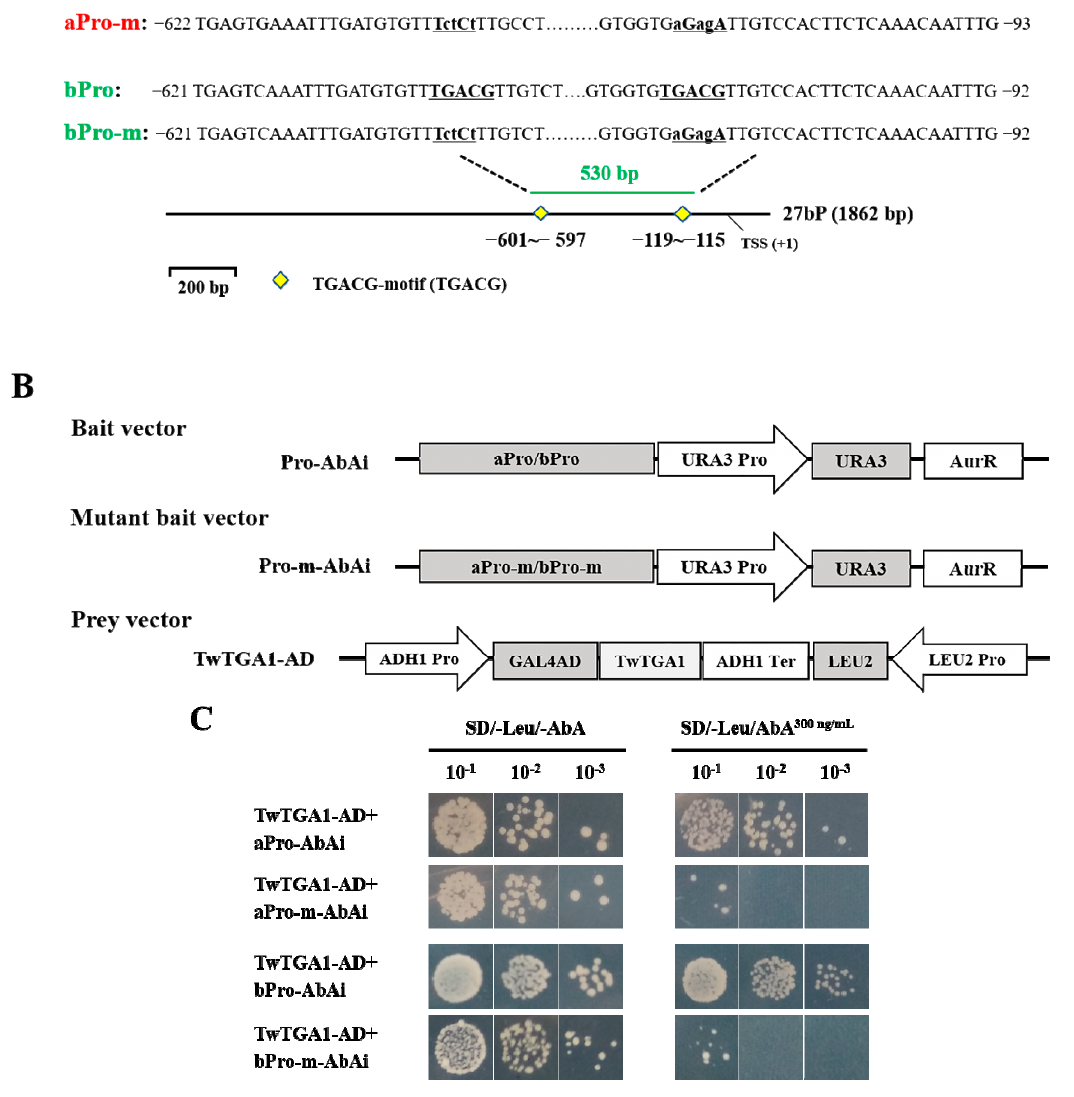
Figure 3. Yeast one-hybrid (Y1H) assays showing that TwTGA1 specifically binds to the TGACG-motif present in the TwTPS27a/b promoters. ( A ) Schematic diagrams of the promoter and mutant promoter fragments in the TwTPS27a ( − 622~ − 93, 530 bp) and TwTPS27b ( − 621~ − 92, 530 bp) used for the construction of the bait and mutant bait vectors. The yellow diamond represents the TGACG-motif. aPro and bPro are both 530 bp containing two ‘TGACG’ elements, while aPro-m and bPro-m are mutated forms of aPro and bPro (‘TGACG’ mutated to ‘TctCt’ by PCR cloning). ( B ) Schematic diagrams of the bait, mutant bait, and prey vectors used for Y1H assays. ( C ) Y1H assays showing the interaction between TwTGA and the TGACG-motif present in the TwTPS27a/b promoters, based on the ability of the transformed yeast strains to grow on SD/ − Leu/AbA 300ng/mL medium with gradient dilution (1/10, 1/100, 1/1000). The transformants grown on SD/ − Leu/ − AbA plate were used as positive controls for transformants growth. Positive transformants were confirmed by spotting yeast cells onto agar medium of SD/ − Leu with 300 ng/mL AbA. These assays were repeated three times with similar results.